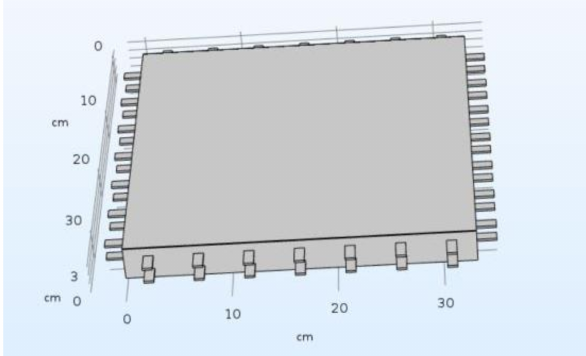
Figure 3. 3D model of the multi-material geometry for the FEM simulation with COMSOL.